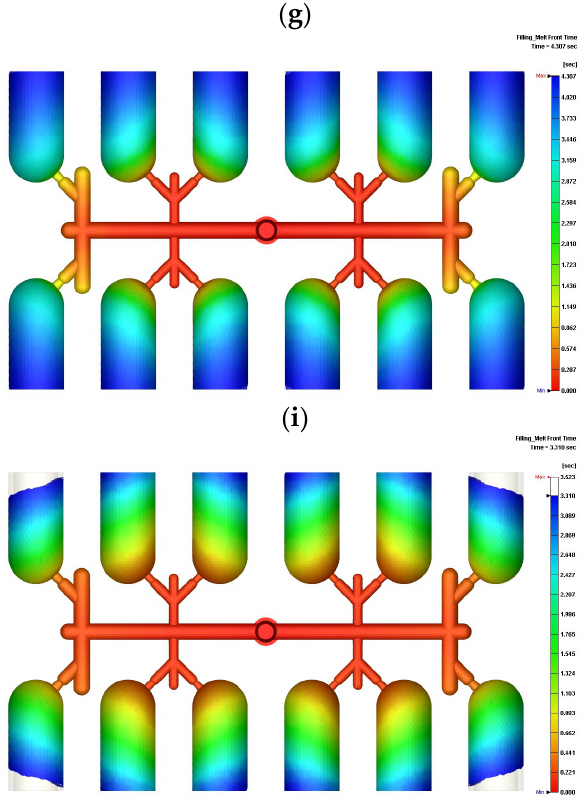
Figure 4. Top view of the filling time and time delay of imbalance by Moldex3D simulation following the L9 orthogonal array : ( a ) Trial 1, filling time 7.228 s; ( b ) Trial 2, filling time 5.958 s; ( c ) Trial 3, filling time 3.69 s; ( d ) Trial 4, filling time 5.066 s; ( e ) Trial 5, filling time 2.874 s; ( f ) Trial 6, filling time 4.071 s; ( g ) Trial 7, filling time 4.319 s; ( h ) Trial 8, filling time 3.808 s; ( i ) Trial 9, filling time 3.523 s. Table 4. Defect determination in the 9 experiments based on Moldex3D simulation results.